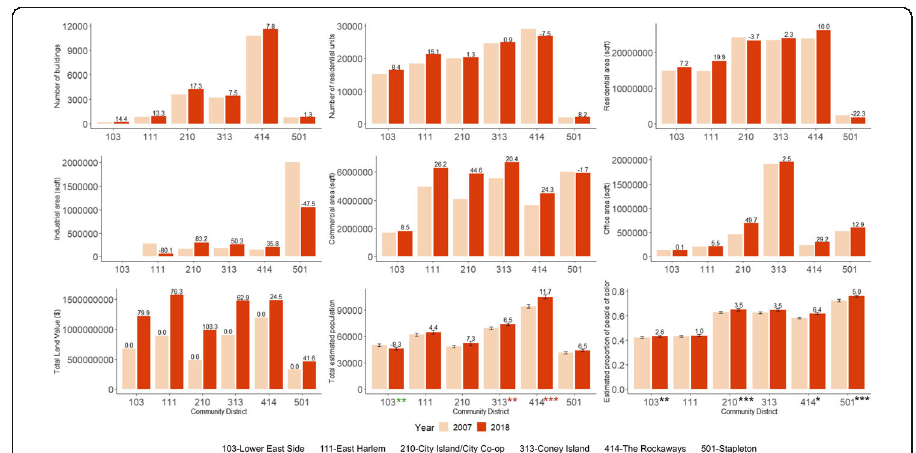
Fig. 3 Changes in exposure over time in FEMA ’ s effective SFHA. Error bars represent the Standard Error of ACS estimates, and asterisks indicate p -values below 0.01 (***), 0.05 (**) and 0.1 (*). No asterisk means that there is no statistically significant difference. Red asterisks indicate that exposure increases, while green asterisks indicate a decrease in exposure. Labels on top of each second bar indicate the %